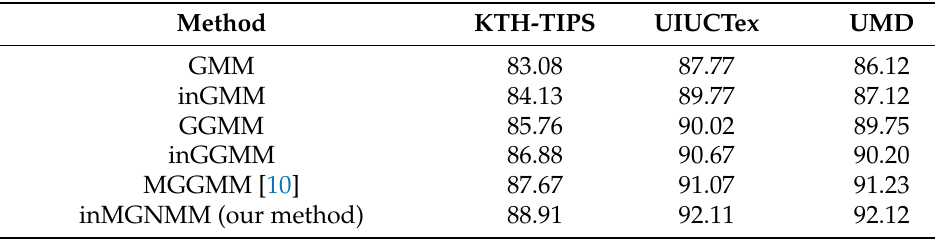
Table 3. Overall classification accuracy rate (%) of different approaches for the three texture datasets using DMD